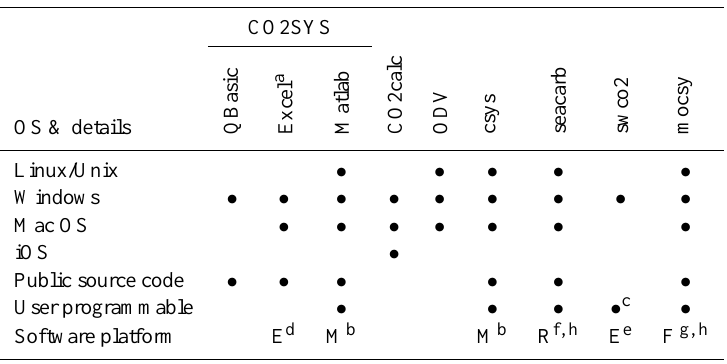
Table 3. Operating system and code details for each package.